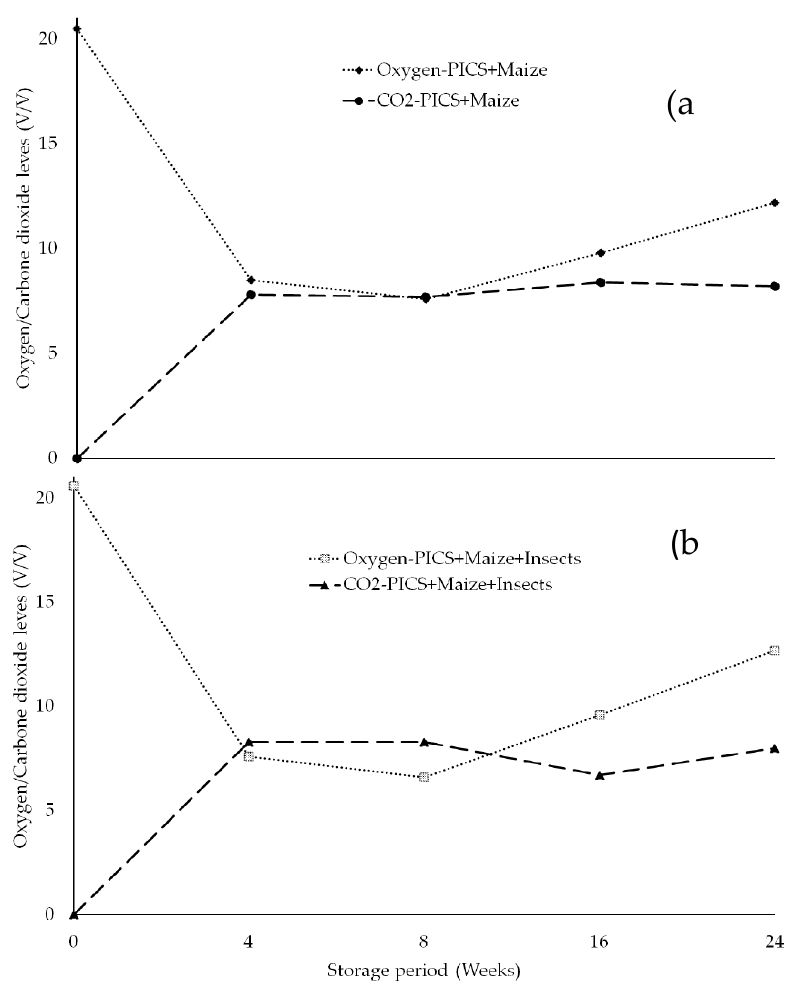
Figure 1. Percent levels of oxygen and carbon dioxide after 24 weeks of storage in ( a ) PICS bags filled with maize grain only and ( b ) PICS bags filled with maize grain and infested with insects ( P. truncatus and S. zeamais ). Table 1. E ff ect of treatment and storage period on percentage grain moisture content of maize stored for up to 24 weeks at the Kiboko KARLO research station in Kenya.